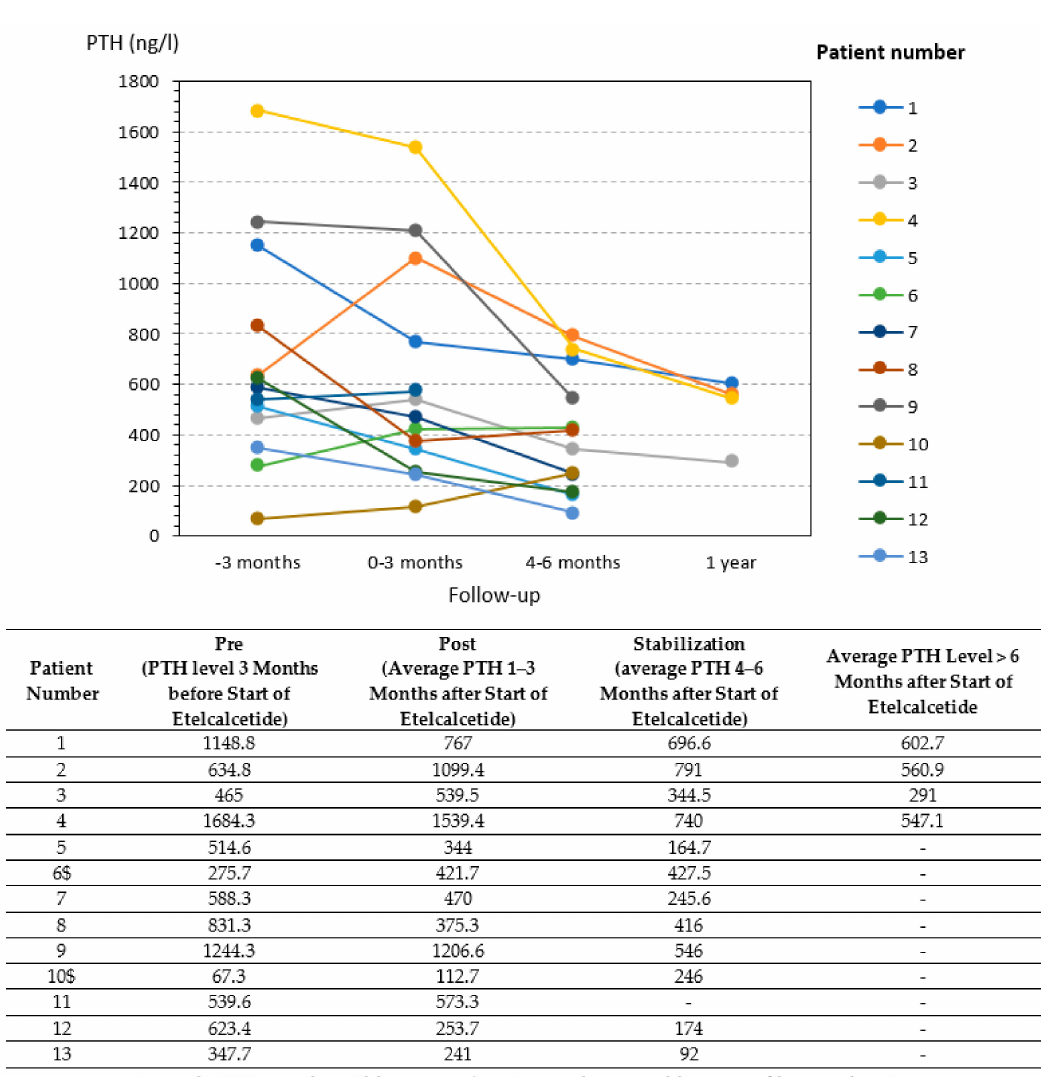
Figure 4. Parathyroid hormone trends in the study